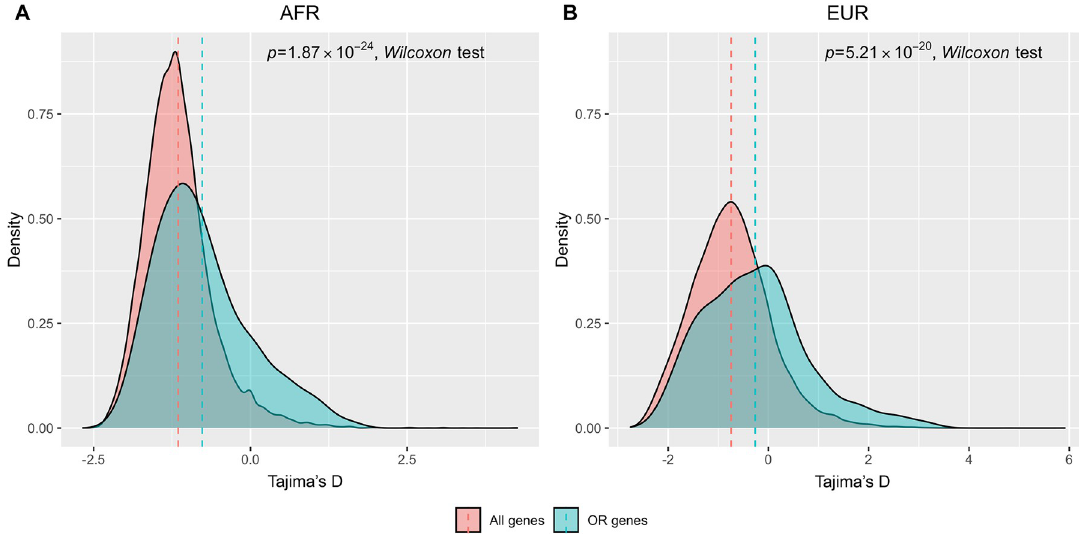
Fig 2. The human functional OR genes tend to have a higher Tajima’s D than the genome average. Comparisons of Tajima’s D between functional OR genes and all genes in the human genome. (A) In AFR. (B) In EUR.